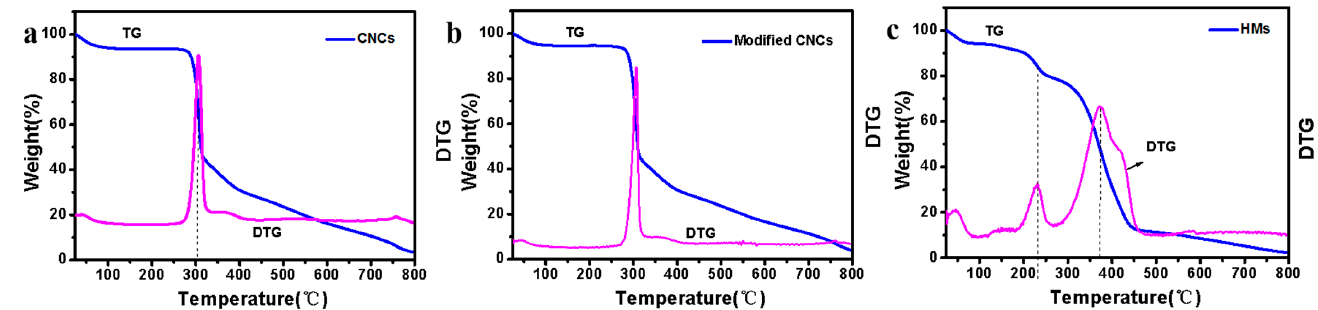
Figure 4. Thermogravimetric analysis (TGA, in blue) and differential thermogravimetry (DTG, in pink) curves of ( a ) CNCs, ( b ) modified CNCs and ( c ) HMs.